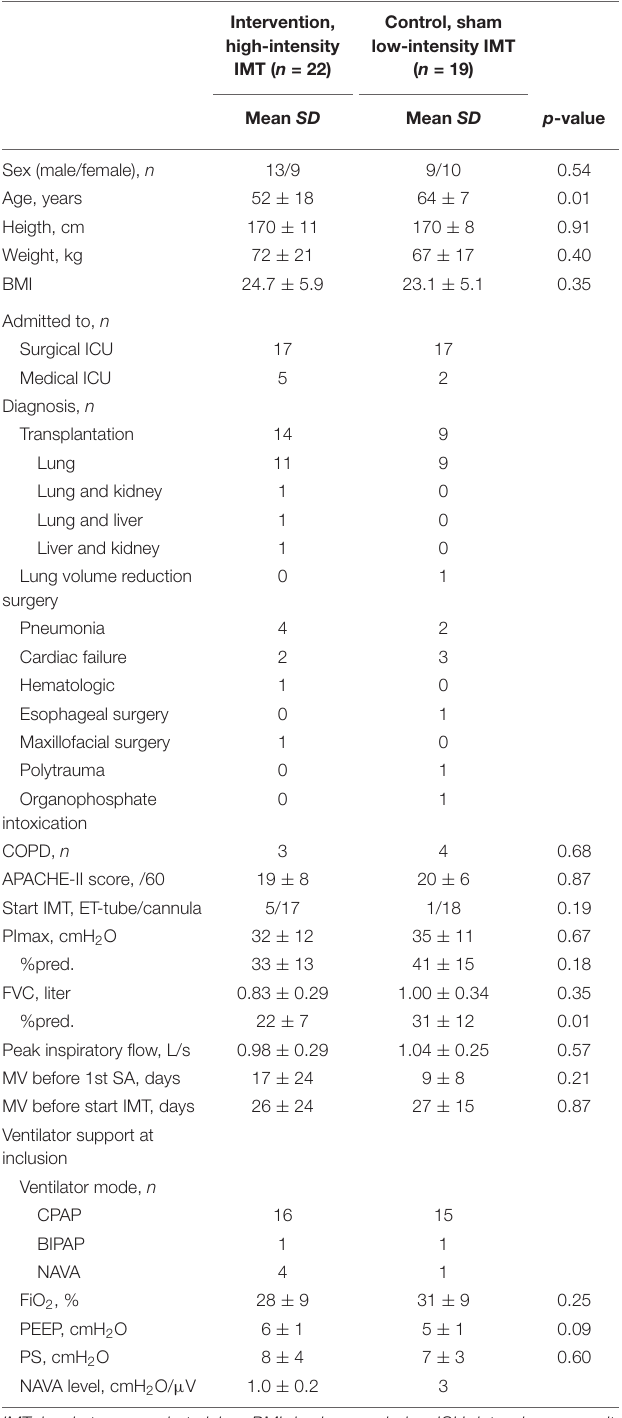
TABLE 1 | Baseline characteristics.